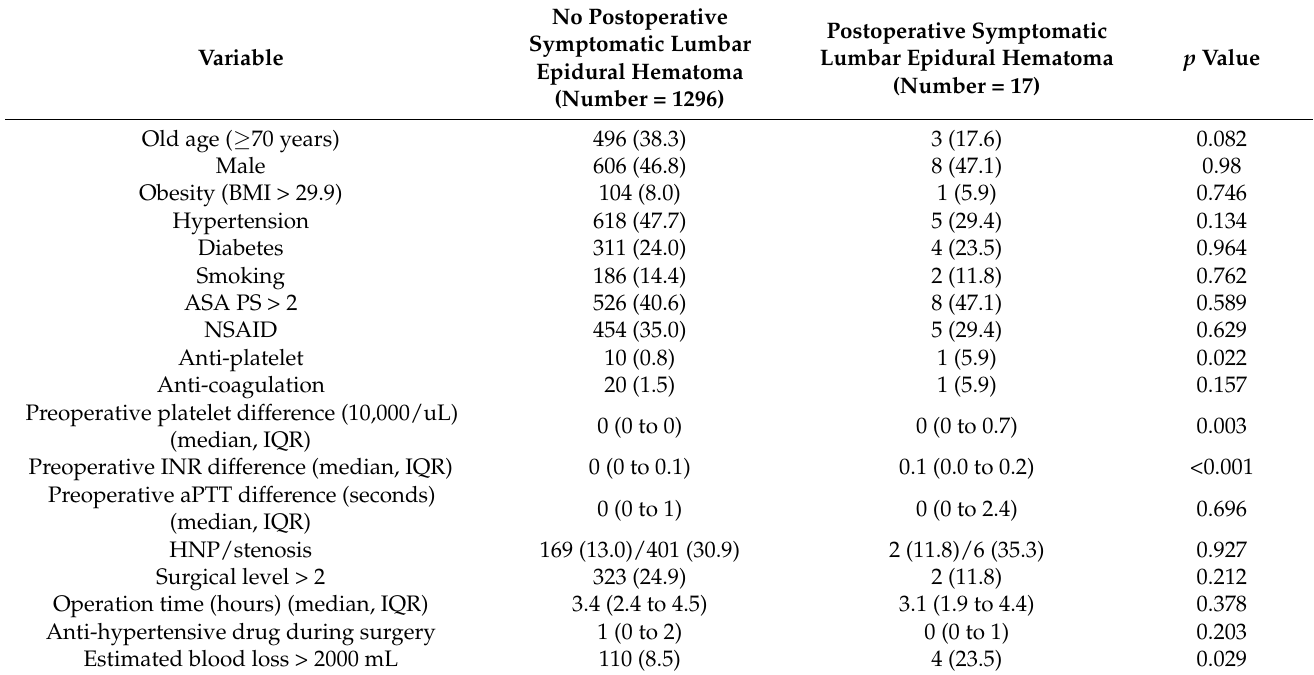
Table 1. Demographic and perioperative data of patients who underwent posterior lumbar spinal fusion